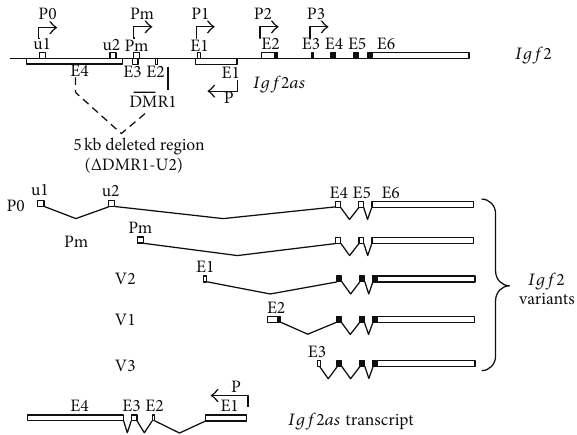
Figure 1: Structure of Igf2 gene, Igf2as , and Δ DMR1-U2 mutation. The arrows indicate the five promoters (P0, Pm, P1, P2, and P3) for Igf2 and(P) for Igf2as . DMR1 indicates the position of the DMR1 regulatory region. V1, V2, V3, P0, and Pm indicate the five variants of Igf2 gene.The5 kbdeletedregionin Δ